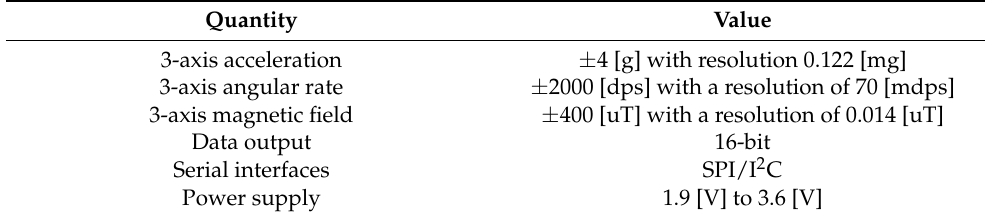
Table 1. Specifications of LSM9DS1 IMU sensor.